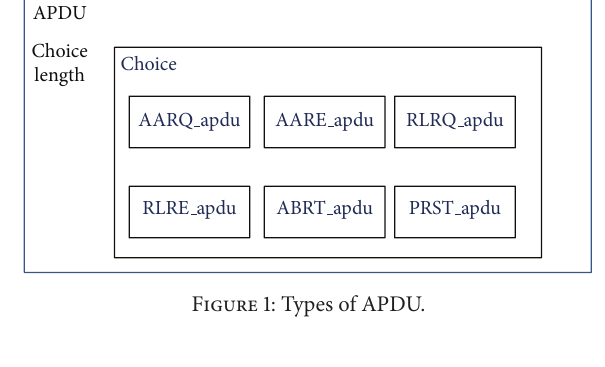
Figure 1: Types of APDU.